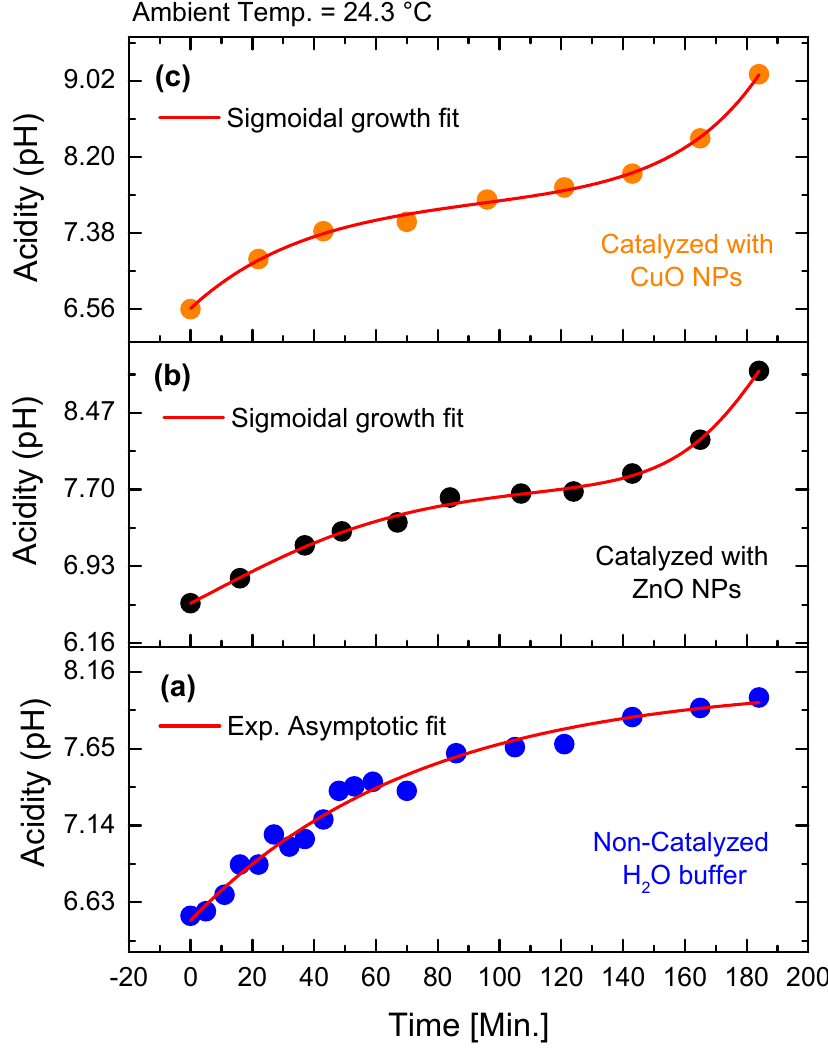
Figure 8. Acidity (pH) versus the period of Time characteristics for the non-catalyzed system and the systems catalyzed with CuO NPs and ZnO NPs.